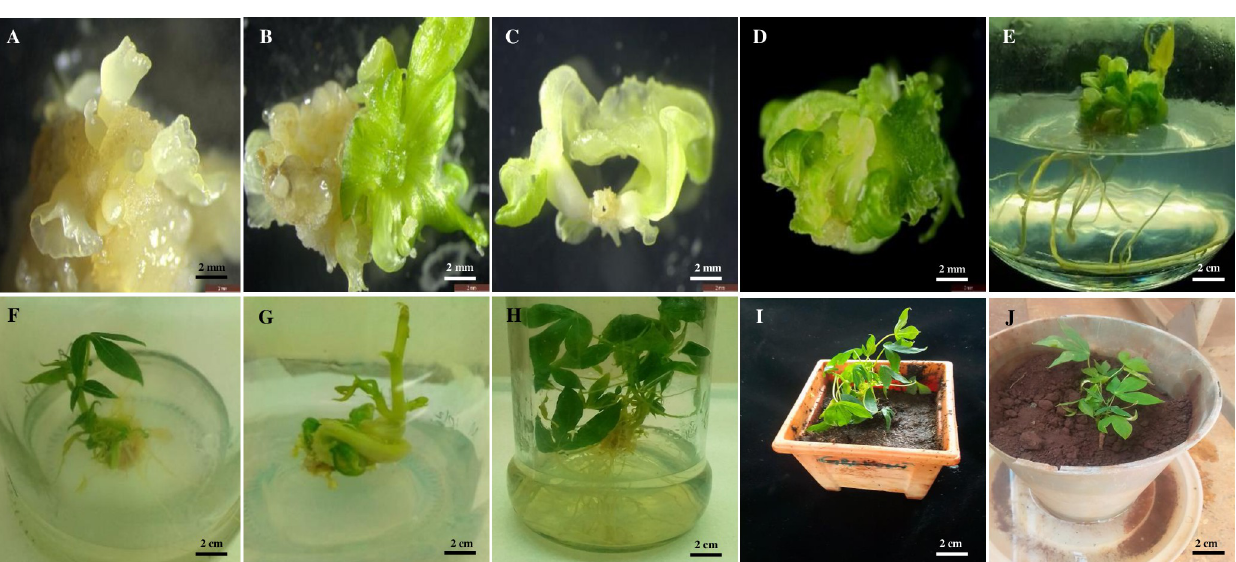
increase in cell densities from 2.0 × 10 5 p/mL to 3.0 × 10 5 p/mL. Calli obtained from culture den-